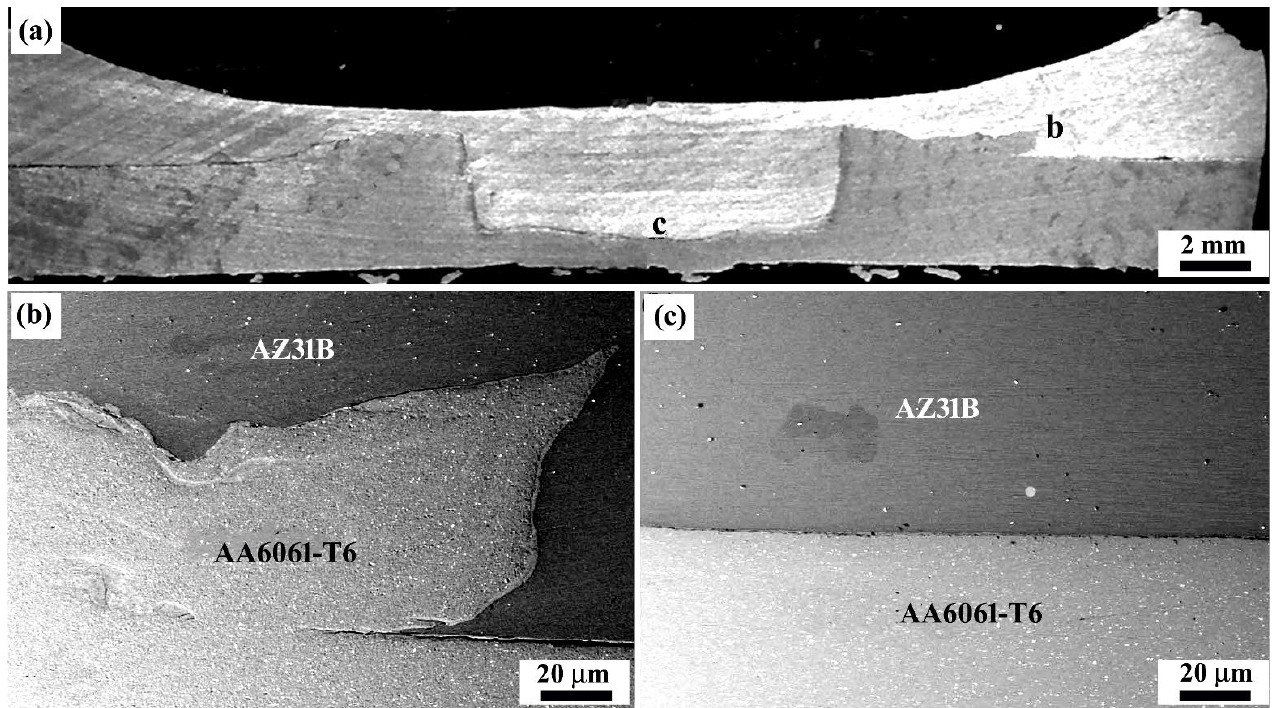
Figure 10. Macrostructure of various regions of a dissimilar (Mg/Al) C-FSSW joint. ( a ) A typical macrograph of the dissimilar (Mg/Al) C-FSSW joint. ( b , c ) are detailed magnified views of the re- gions in a.